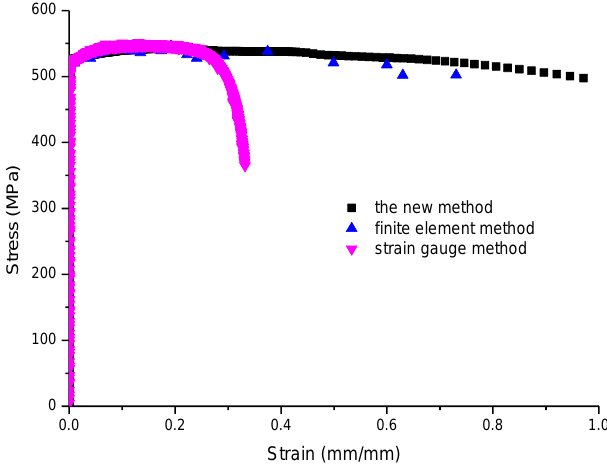
Figure 12. Comparison of the engineering stress-engineering strain of three methods.